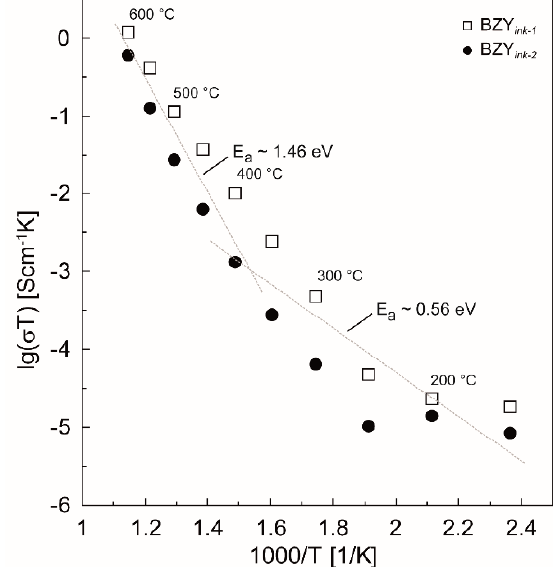
Figure 14. Arrhenius Plot of the two different samples BZY ink- 1 and BZY ink- 2 in the temperature range from 150 to 600 °C. The dotted grey lines are a guidance for the eyes indicating two different regimes of activation energies. The slopes of these grey lines represent the averaged E a values obtained from the fitted graphs in the two regions i.e., below approximately 400 °C and above.